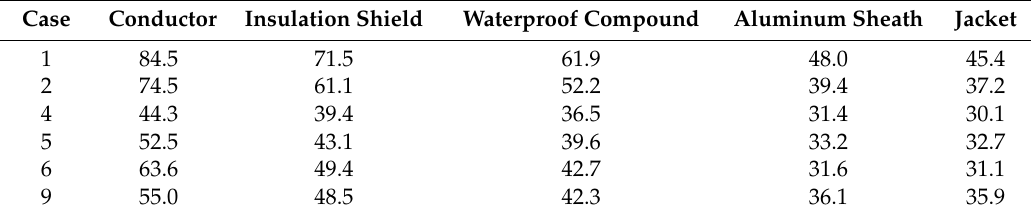
Table 5. Steady-state temperatures of the tested cables (°C).